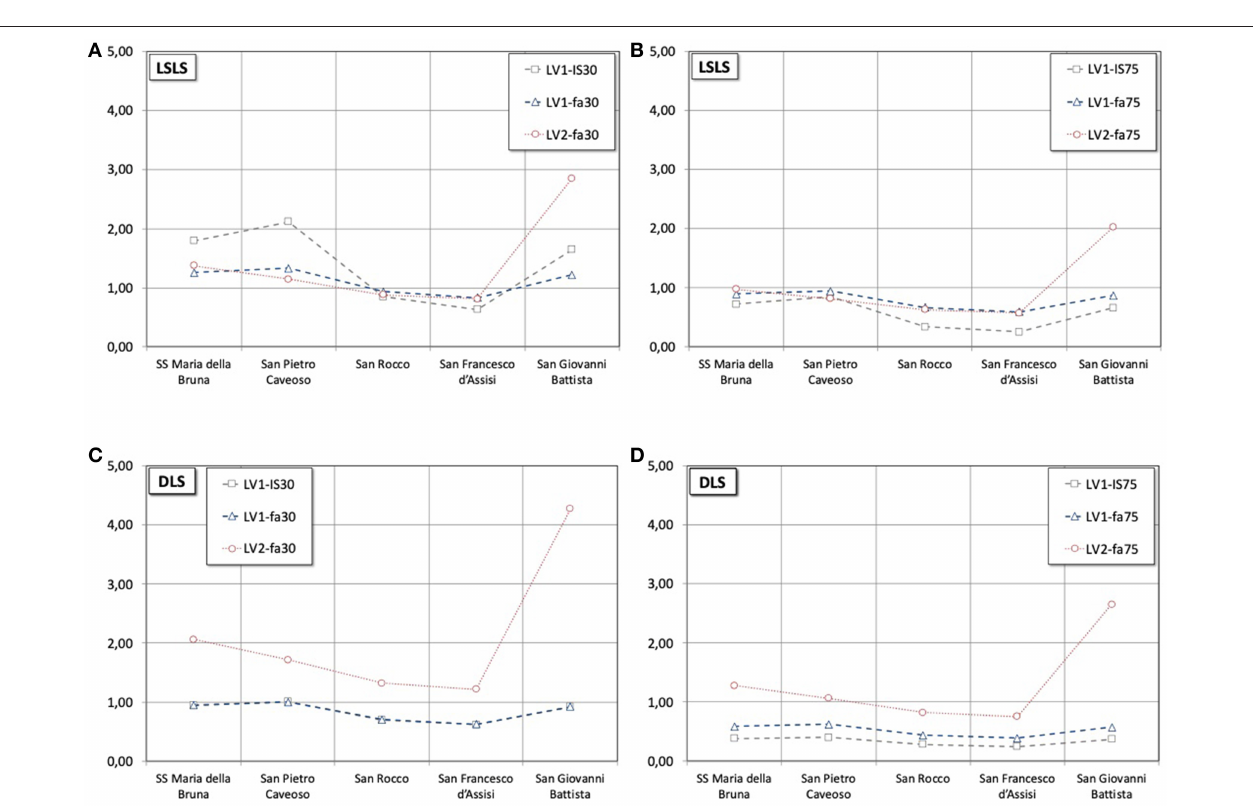
Frontiers in Built Environment |